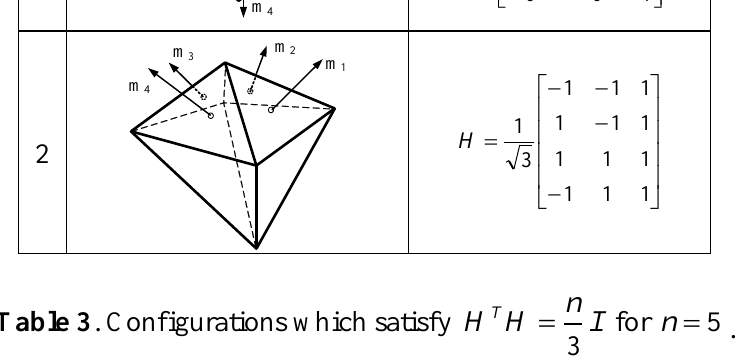
Table 3 . Configurations which satisfy Configuration Diagram